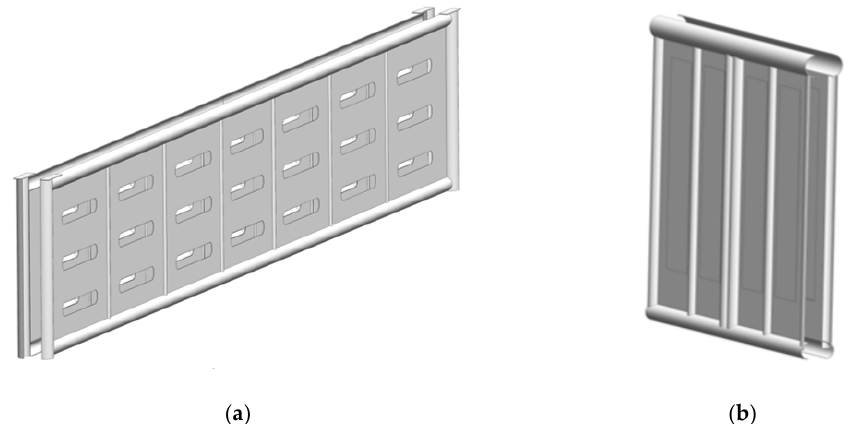
Figure 2. Components of the bearing structure of an open wagon of double walls ( a ) side wall; ( b ) end wall.